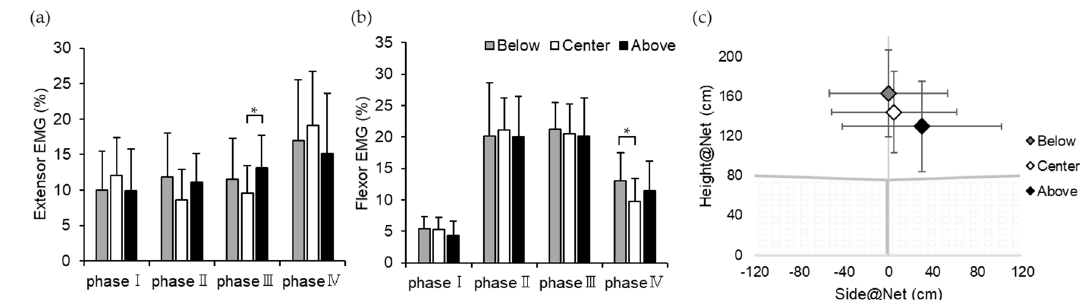
Figure 3. Average EMG for the extensor carpi radius muscle (ECR) ( a ) and the flexor carpi radialis muscle (FCR) ( b ) at each phase three impact location patterns. ( c ) Ball passing position on the net. * Indicates significant difference ( p < 0.05) between impact location